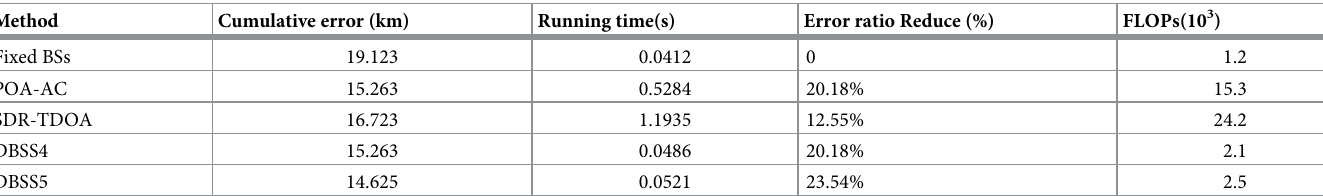
Table 1. Comparison of various indicators with different